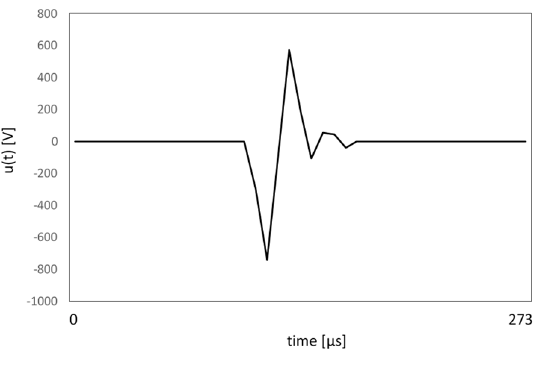
Figure 6. Extracted transient using wavelet transform and formula (5).